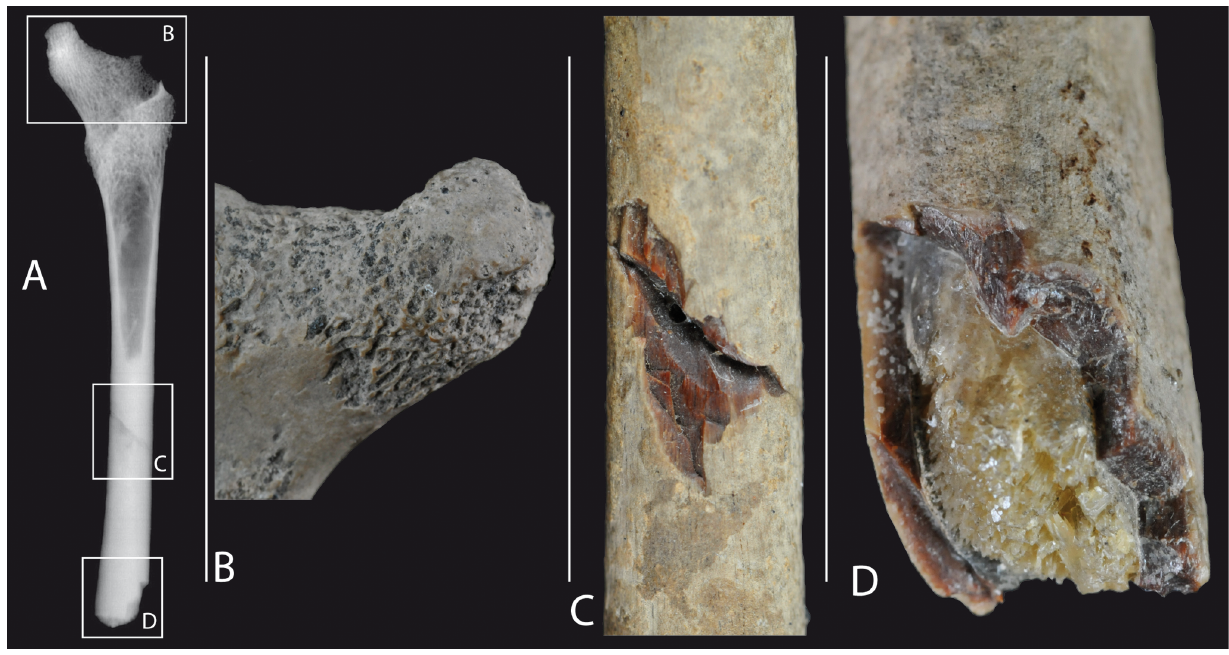
Figure 3. Taphonomic details of Trinil 5703. A: radiograph in anterior view showing an opaque filling in the distal portion of the preserved medullar cavity; B : detail of the neck in posterior view, showing fluvial abrasion in weakly acid conditions; C : detail of the refitted break of the shaft that we attribute to breakage during excavation; D : detail of the distal break of the shaft, which is likely also excavation damage, and the calcitic filling inside the medullar cavity, as also seen on the radiograph.